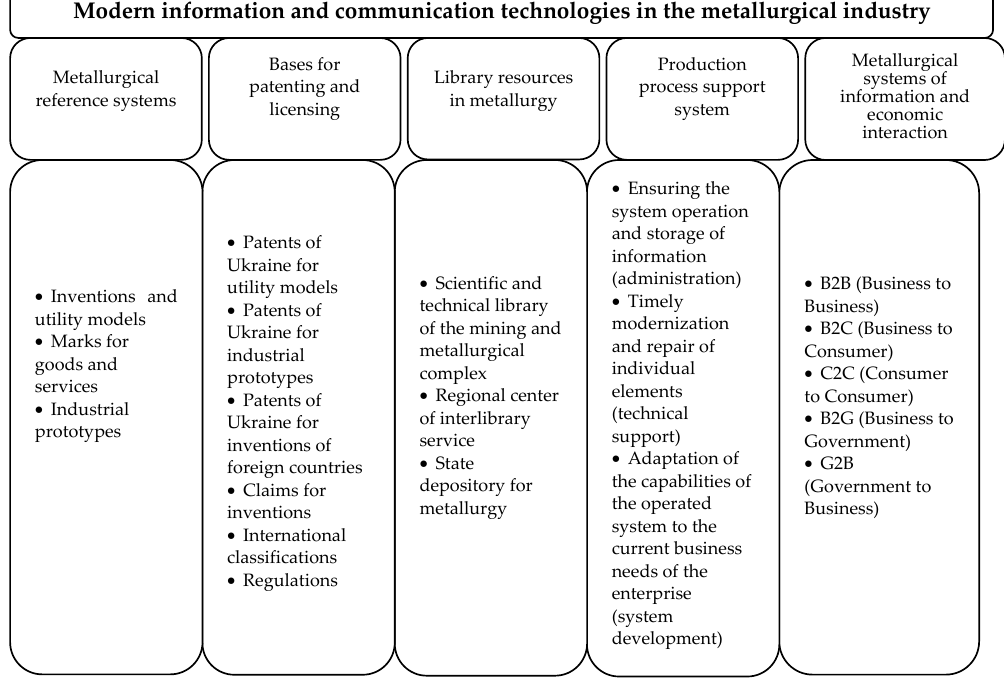
Figure 2. Modern information and communication technologies in steel industry in Ukraine. Source: own study based on the data (Shvachich et al. 2017, pp. 70–75).